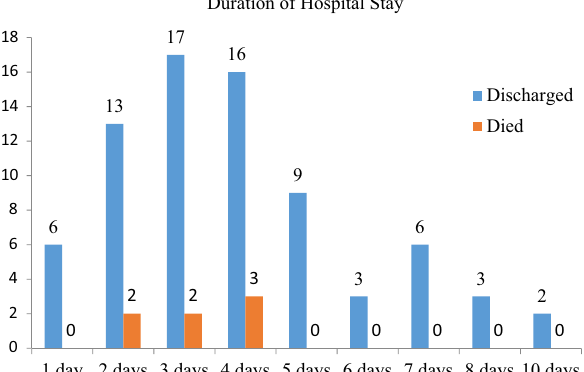
Figure 4. Overall distributions of poisoned children and their short-term outcomes over the course of their hospital stay.